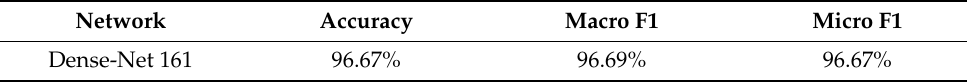
Table 15. The evaluation results on INRIA and MSMT17 datasets.